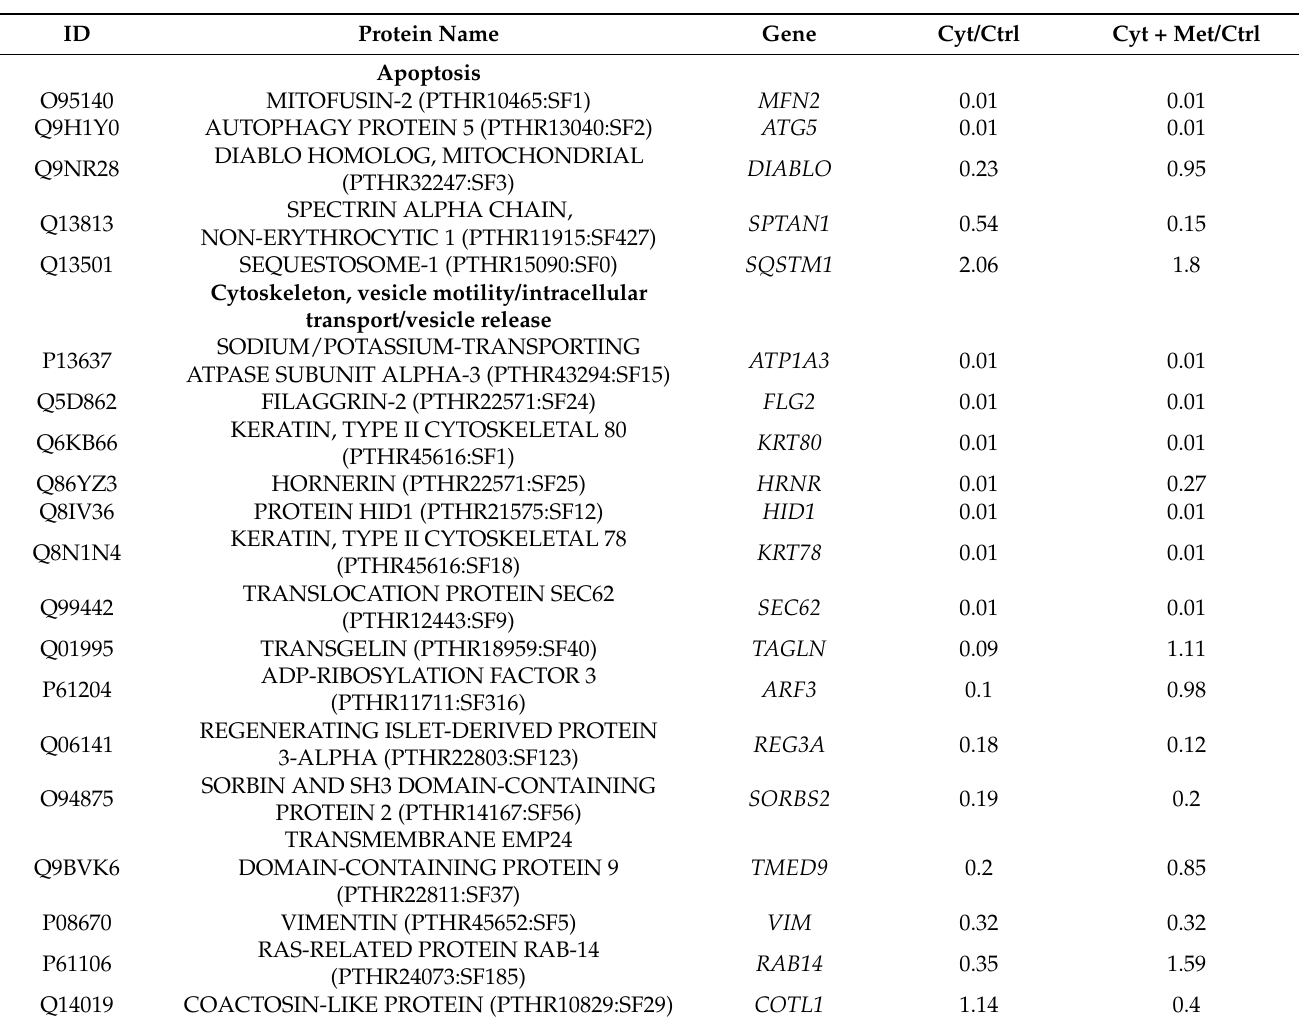
Figure 3. Comparison of differentially expressed proteins in cytokines vs. control and cytokines plus metformin vs. control. ( A ) Venn diagram showing the number of differentially expressed proteins in common between Cyt vs. Ctrl and Cyt + Met vs. Ctrl. ( B ) Mosaic plot showing the directionality of the significantly affected proteins in common between the two different comparisons. Table 1. List of proteins significantly modulated by both cytokines and cytokines plus metformin vs. the respective control